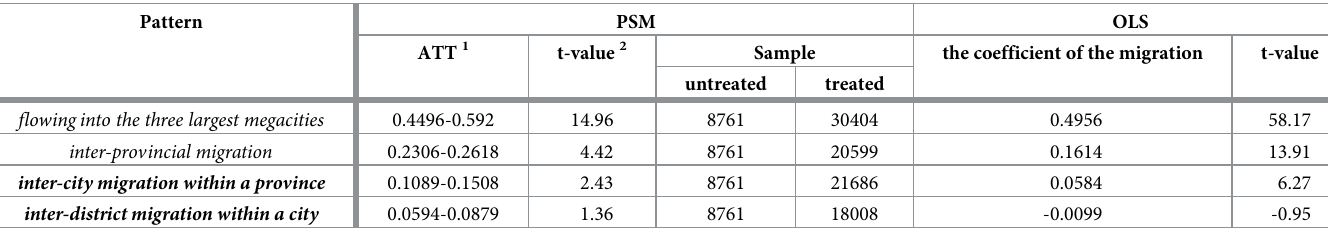
Sample the coefficient of the migration t-value treated